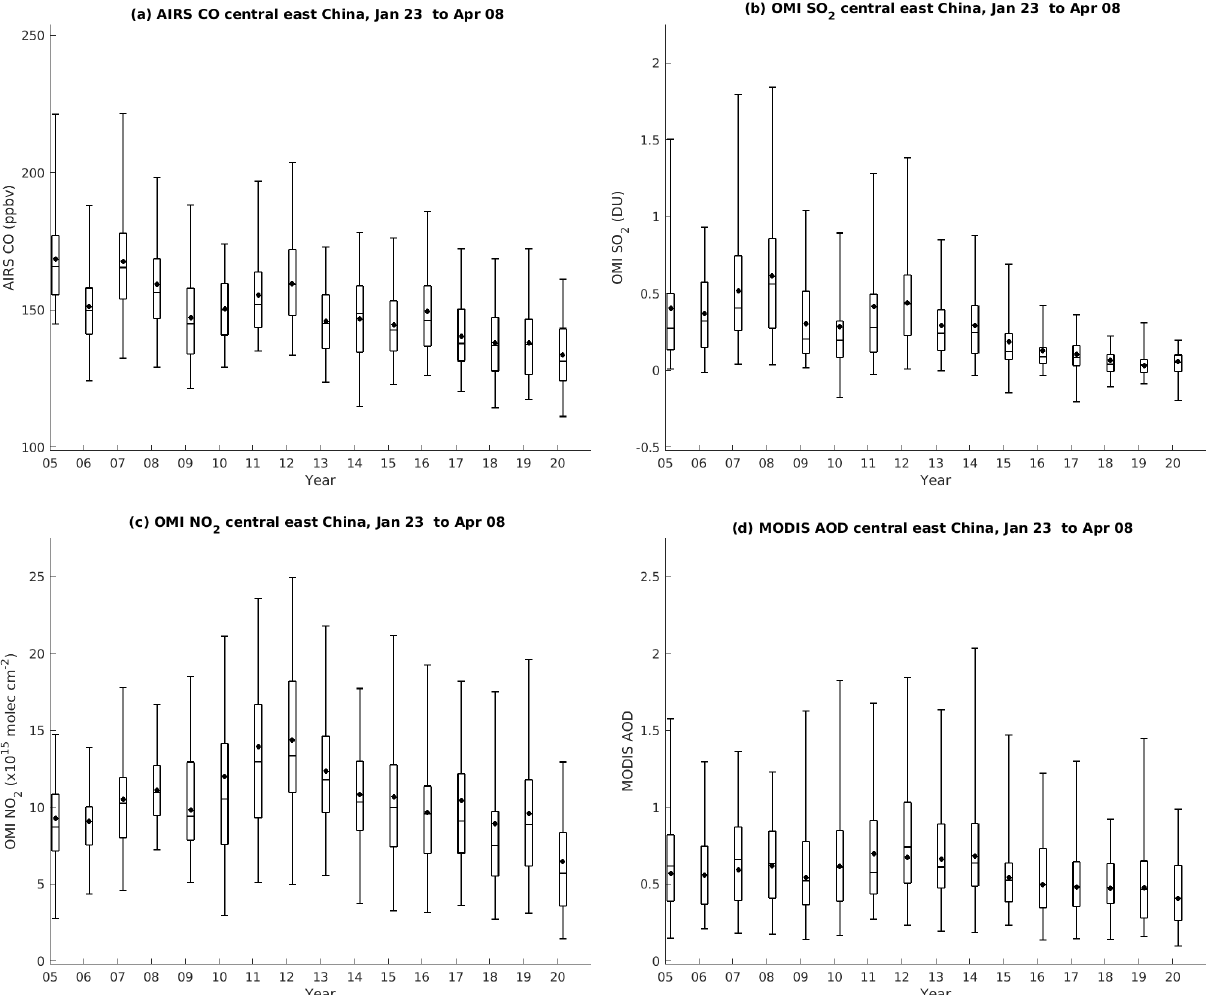
Figure 5. The 23 January–8 April box plots over central east China for (a) AIRS CO, (b) OMI PBL SO 2 , (c) OMI tropospheric NO 2 , and (d) Aqua and Terra MODIS AOD from 2005 to 2020. The black box plots show the median, interquartile range, and 2.5th and 97.5th percentiles over all daily data, with the mean shown by the black